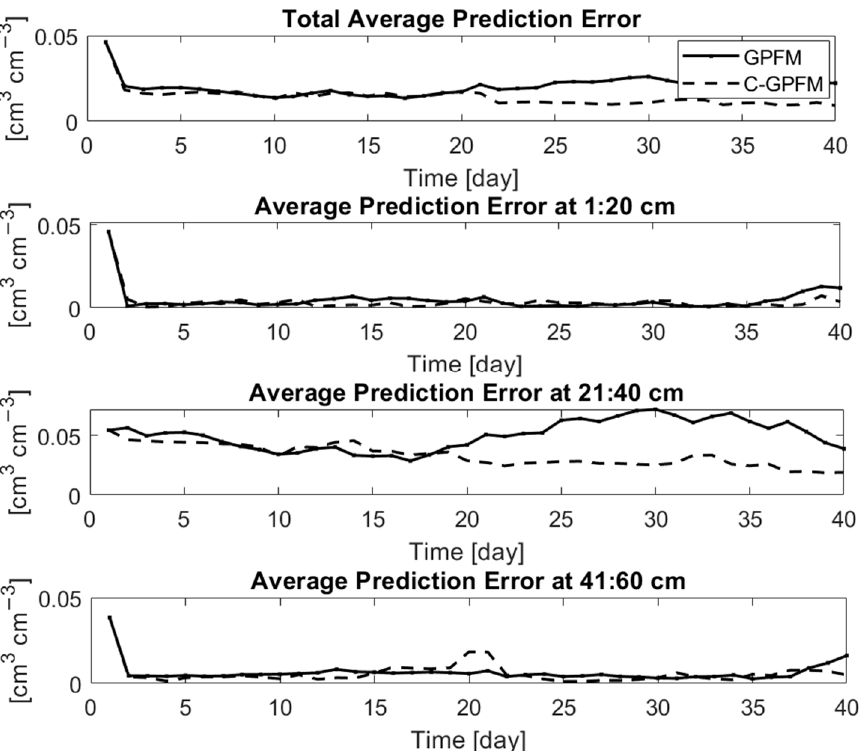
Figure 10. Average of state prediction error for the next 20 days at each day of assimilation by C-GPFM and GPFM for Case Study #2.